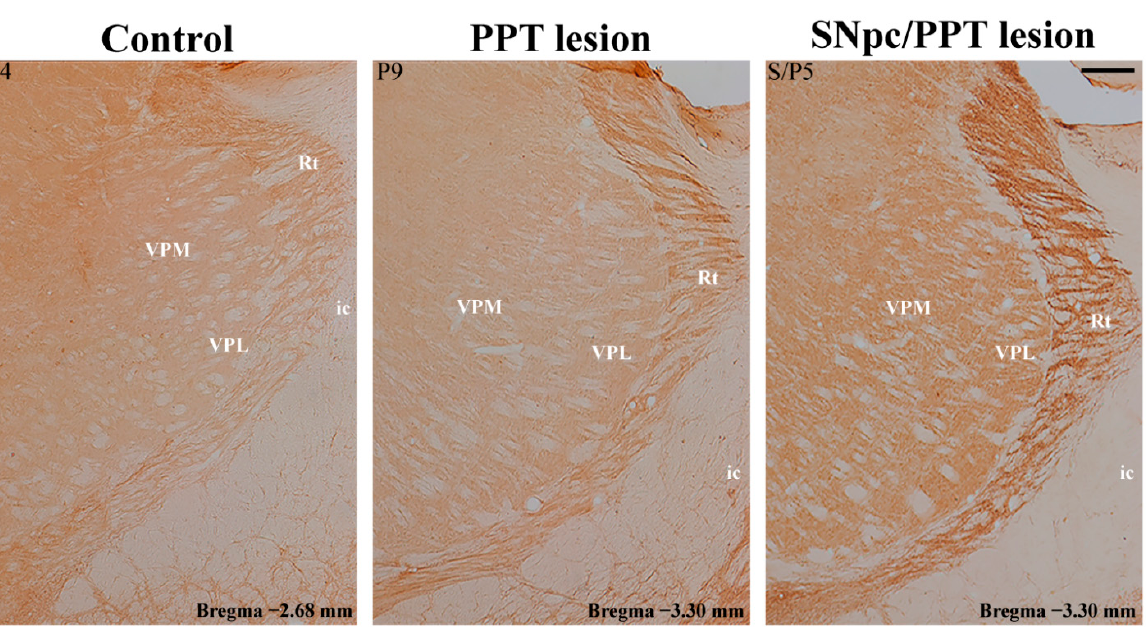
Figure 12. Individual examples of MAP2 and PSD-95 immunostaining alteration within RT in the distinct rat models of PD neuropathology. ( A ) The typical individual examples of MAP2 immunoreactivity within RT in the control rat (Con- trol, C4), rat with PD cholinopathy (PPT lesion, P9), and hemiparkinsonian rat with PD cholinopathy (SNpc/PPT lesion, S/P5). Scale bar is 200 μ m. ( B ) The typical individual examples of PSD-95 immunoreactivity within RT in the control rat (Control, C4), rat with PD cholinopathy (PPT lesion, P9), and hemiparkinsonian rat with PD cholinopathy (SNpc/PPT le- sion, S/P5). Rt—reticular nucleus; VPM—ventral posteromedial thalamic nucleus; VPL—ventral posterolateral thalamic nucleus; ic— internal capsule. Scale bar is 200 μ m. Whereas the partially increased MAP2 expression in RT of the rats with PD cholinopathy was followed by the suppression of PSD-95 expression, the enhanced MAP2 immunoreactivity in RT of the hemiparkinsonian rats with PD cholinopathy was followed by PSD-95 expression similar to control level. 2.7.2. PV+ Interneurons Alteration of RT and PSD-95 Expression in the Distinct Rat Models of PD Neuropathology Although there was no alteration of the number of PV+ interneurons and MAP2 expression was partially increased (see Figures S3 and S4), there was the suppression of PSD-95 expression in RT of the rats with PD cholinopathy (Figure S5, PPT lesion). On the